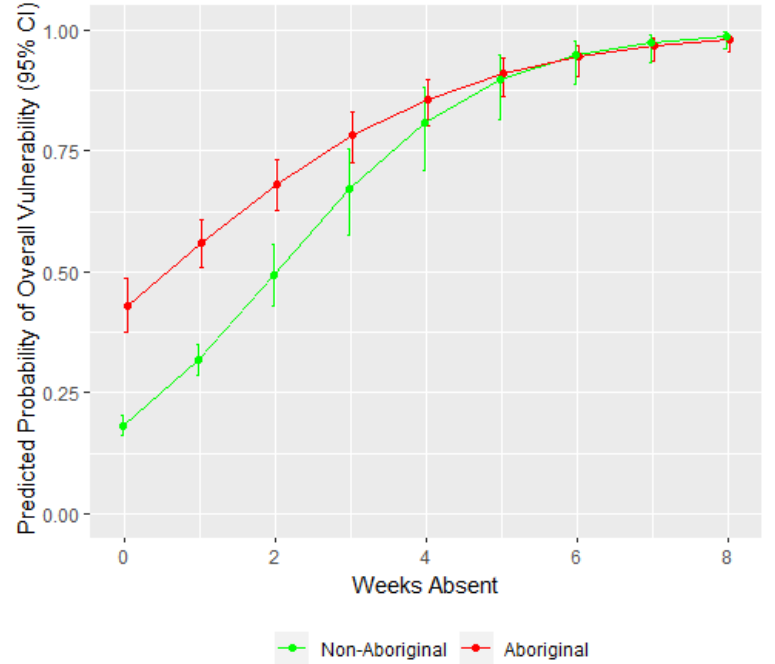
Figure 5. Predicted probability of a child being vulnerable by Aboriginal status and duration of school absence. The figure compares the relationship between the number of weeks children were absent from school and the predicted probability of a child being vulnerable, and 95% confidence intervals, for Aboriginal versus non-Aboriginal children.